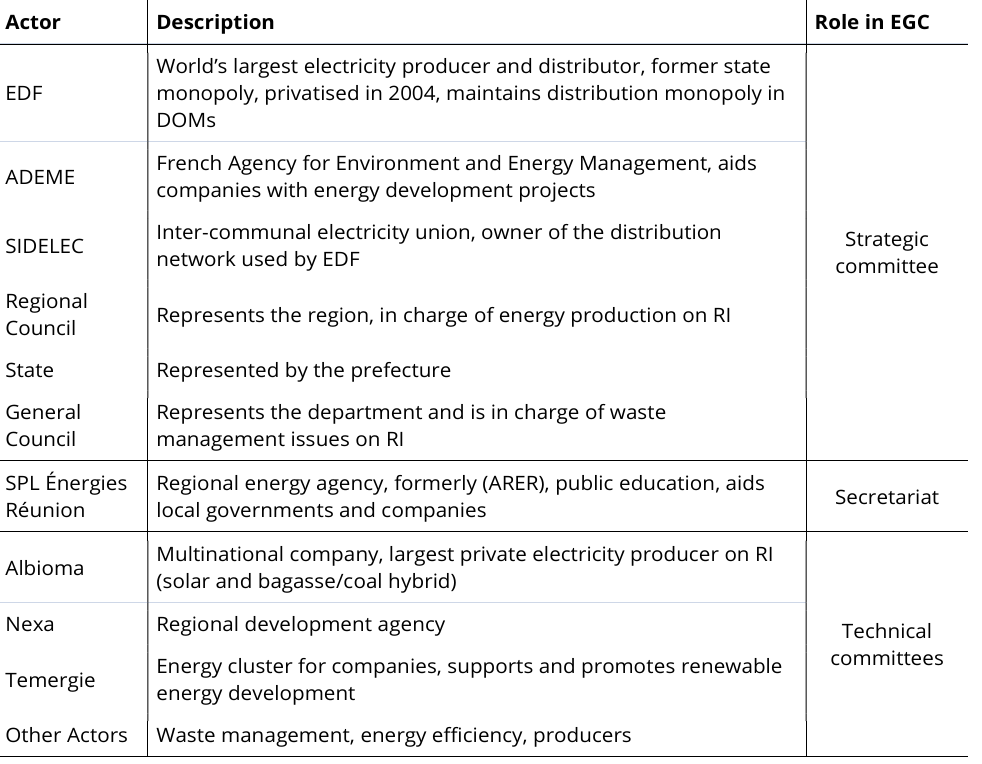
Table 1. Timeframe of regional energy policy development on Reunion Island. Actor